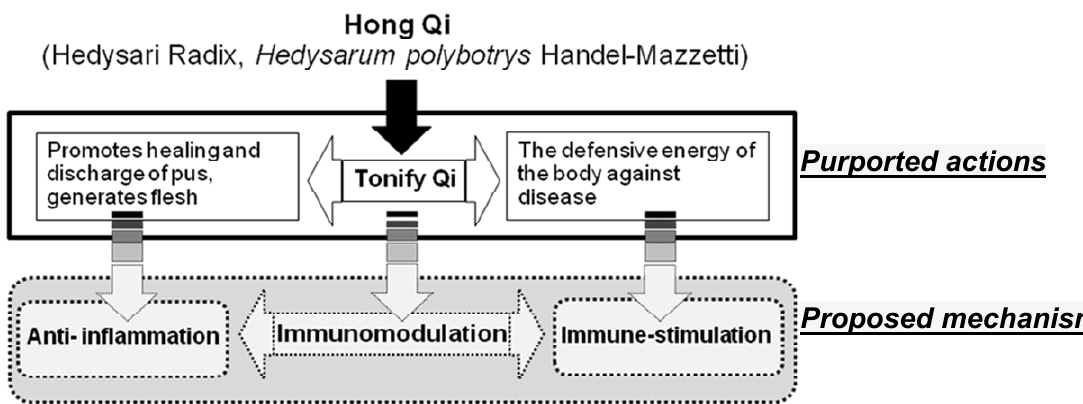
Figure 1. The correlations between traditional and modern pharmacological effects of H. polybotrys .